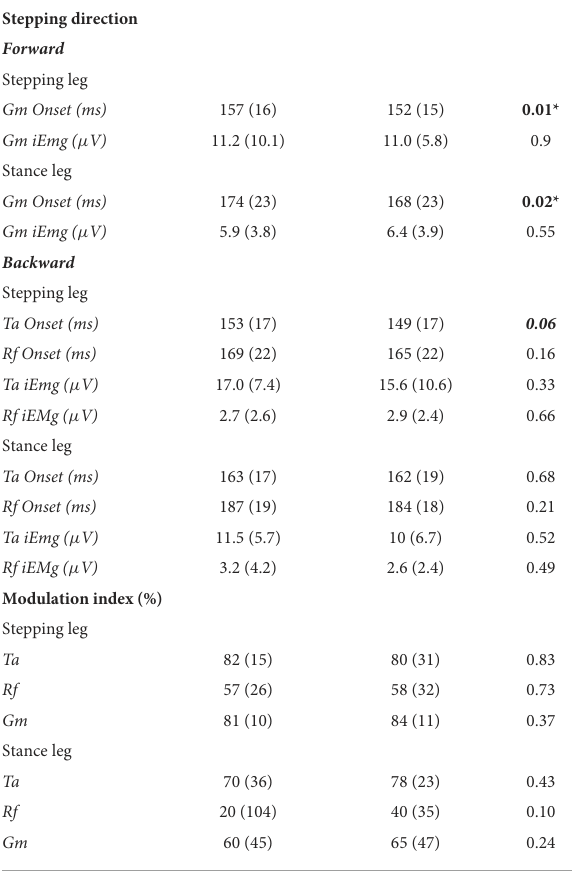
TABLE 3 Mean (SD) pre and post-training values of muscle onset latencies, amplitudes and modulation indices. Pre intervention Post intervention P